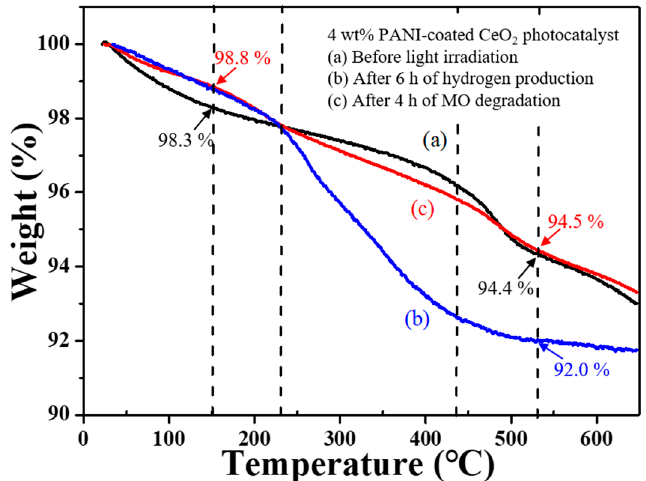
Figure 11. TGA curves of the PC004 photocatalyst (a) before light irradiation, (b) after 6-h of hydrogen production and (c) 4 h MO degradation under visible light irradiation.